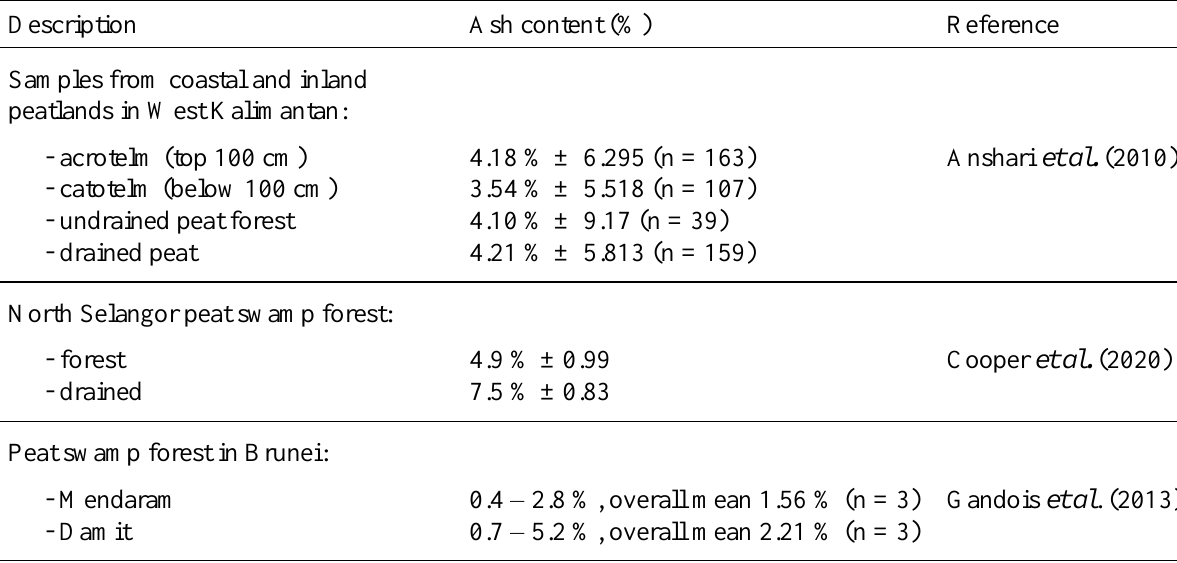
Table 3. Ash contents from tropical peatlands in